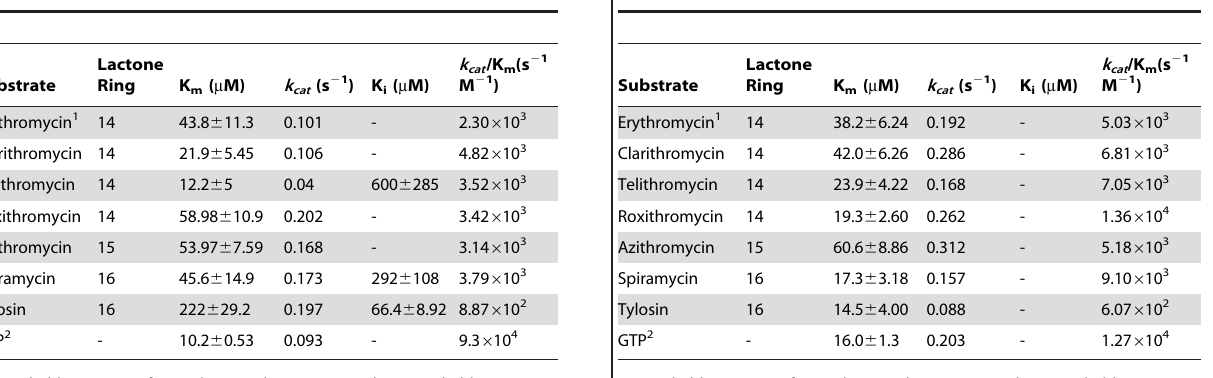
Table 3. Kinetic parameters for MPH (2 9 )-II from B. paraconglomeratum.